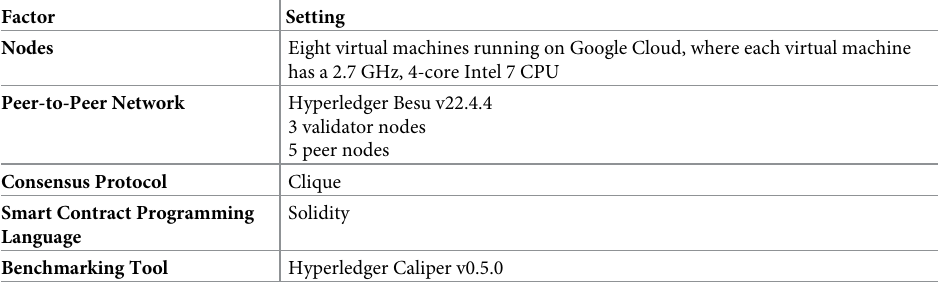
Table 2. Configurations of Hyperledger Besu and the testing environment.